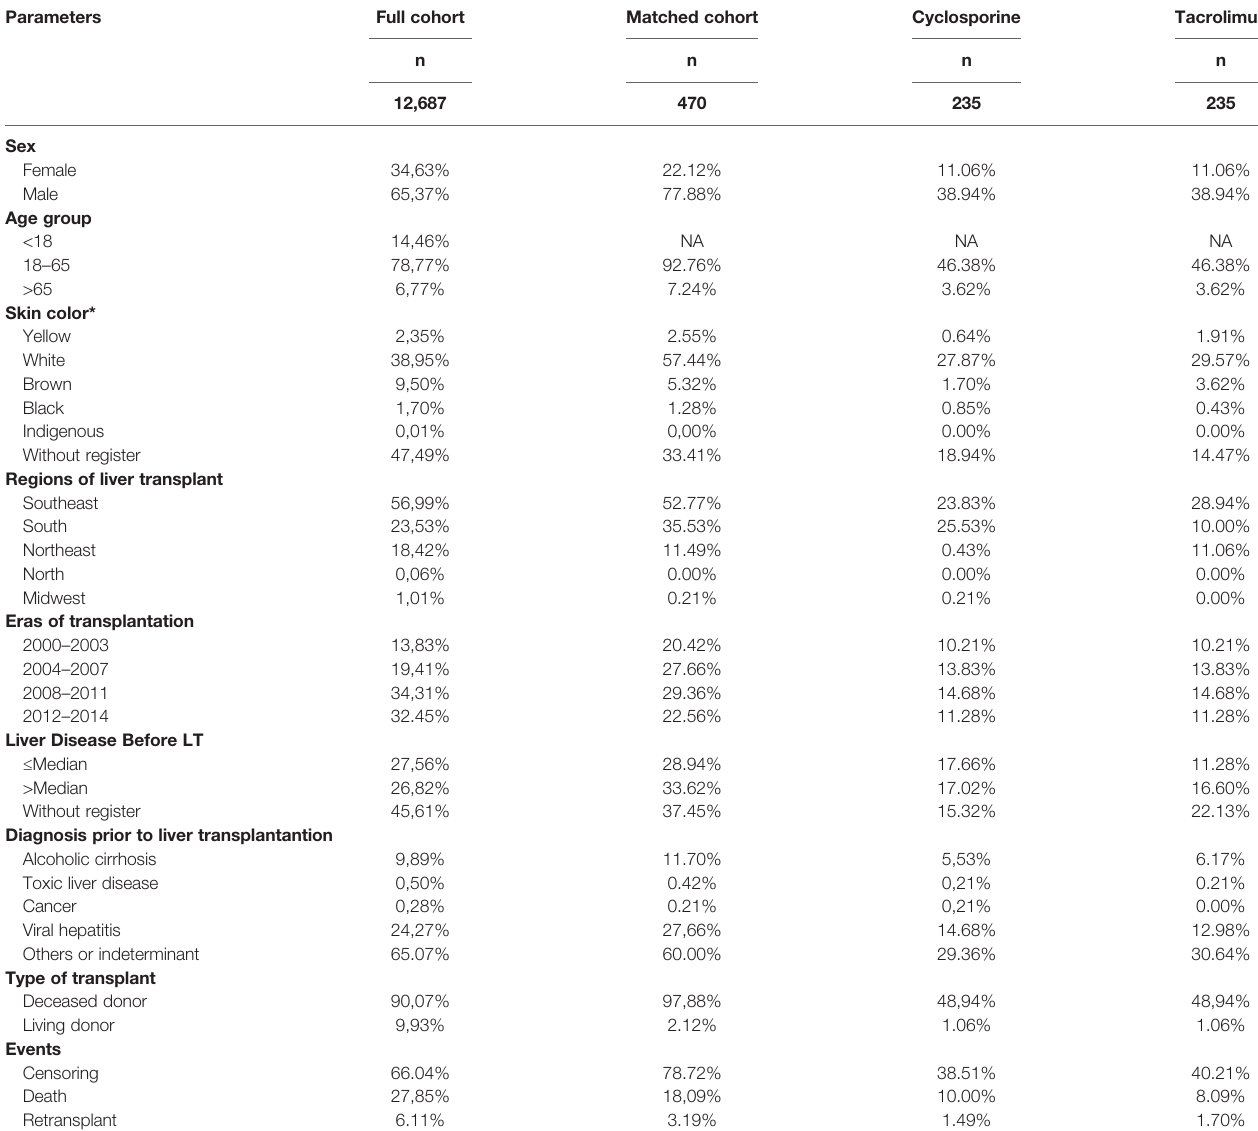
TABLE 1 | Patient